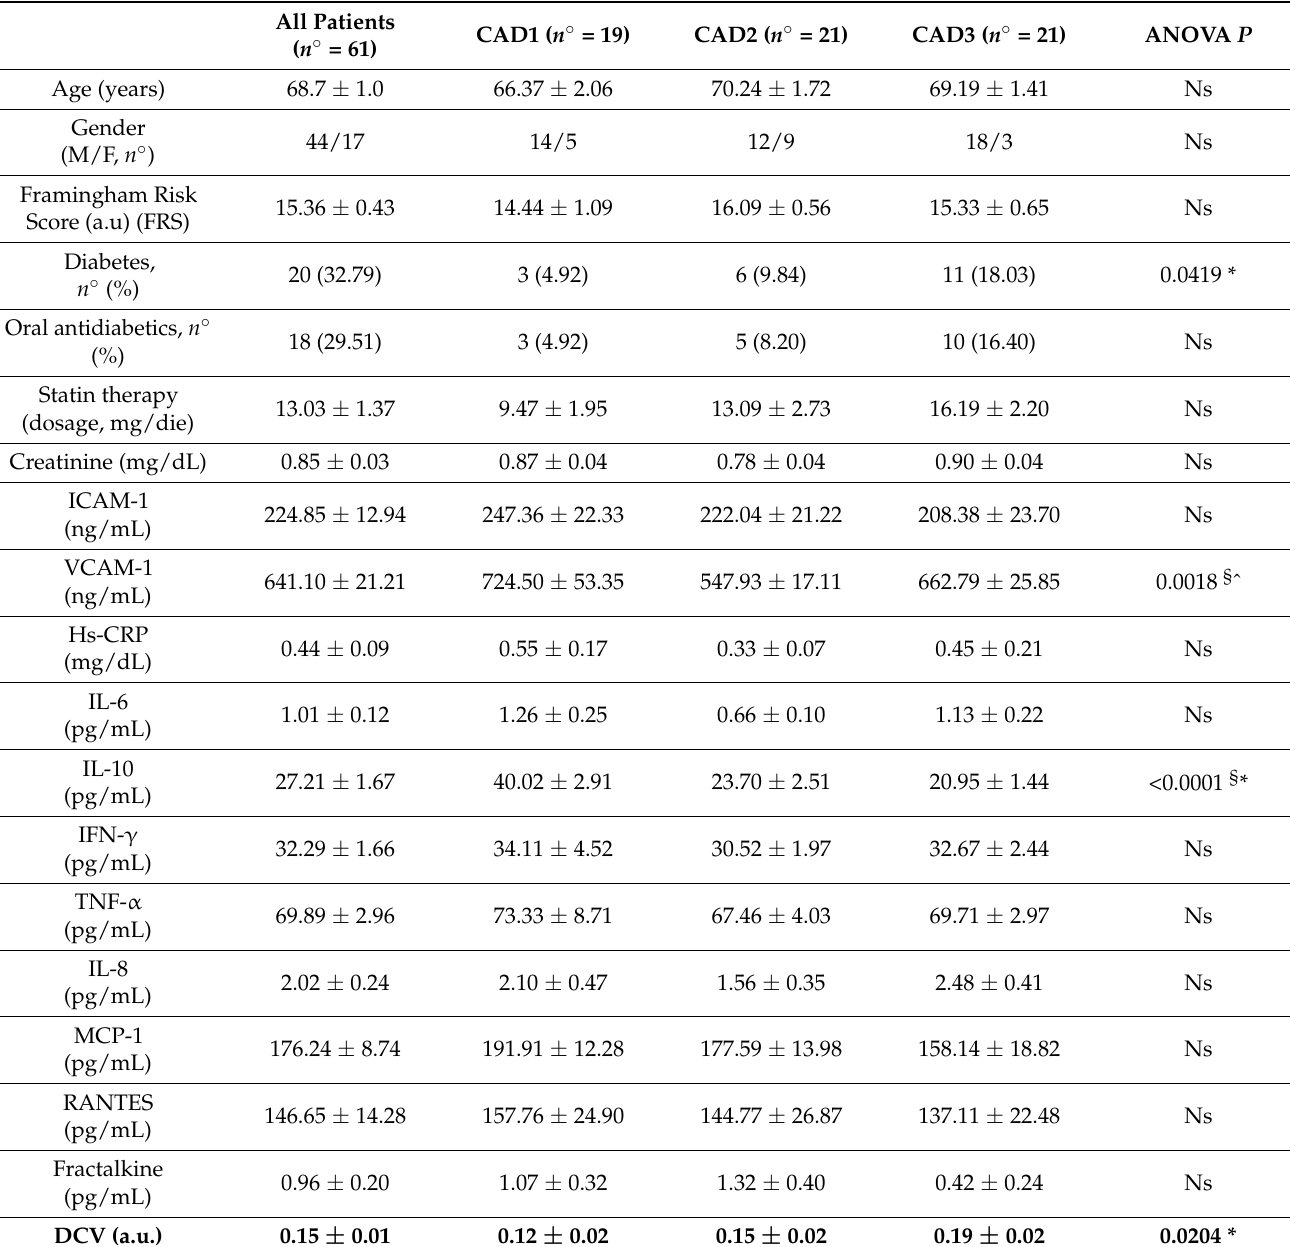
Table 1. Clinical and biohumoral parameters in all patients and by CAD severity